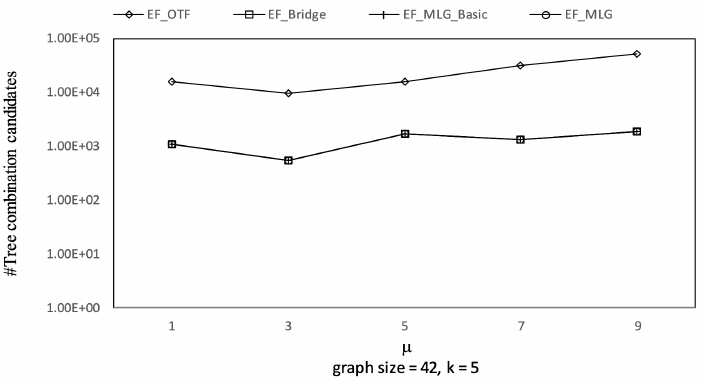
Figure 21. Tree combination pruningon GraphGen vs. µ with graphsize = 42 and k = 5.